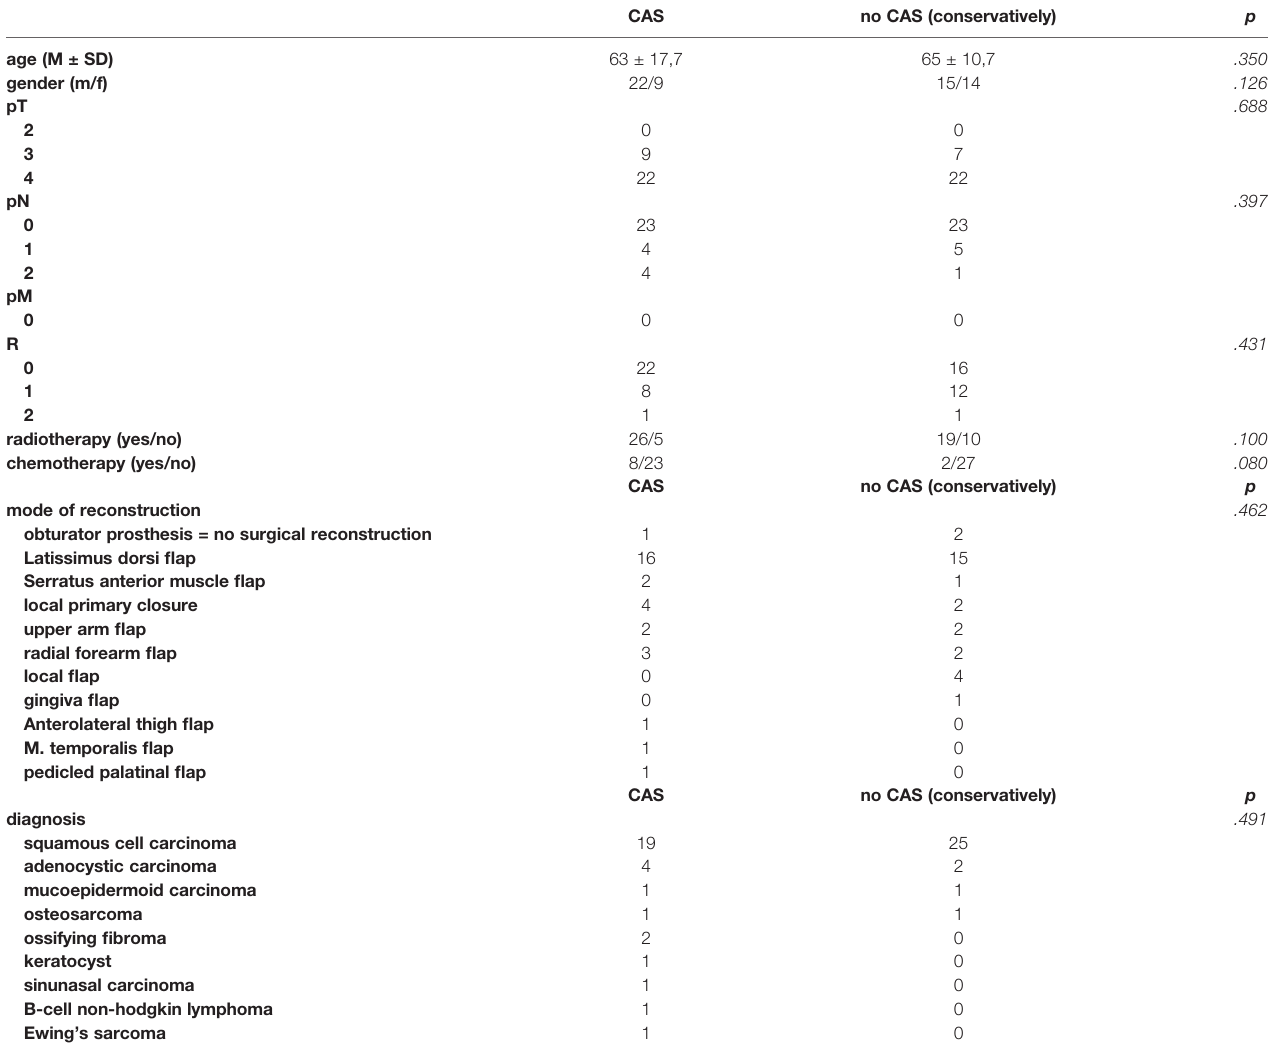
TABLE 2 | Test characteristics of patients with tumors of the upper jaw treated with the help of CAS in the intervention group compared to the control group treated conventionally without